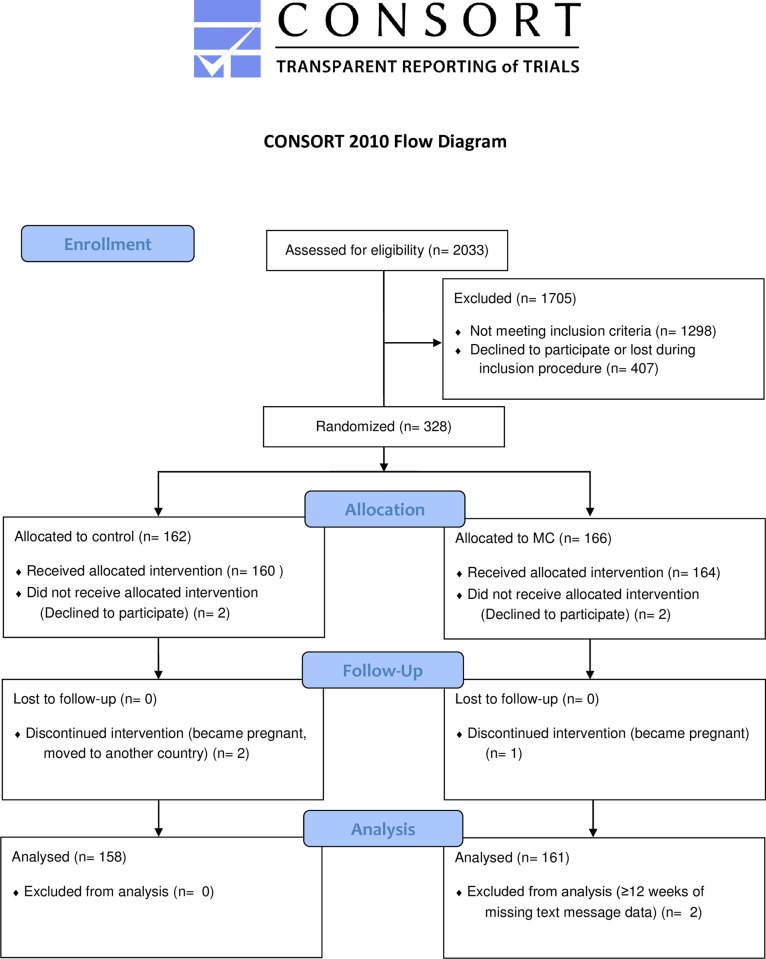
CONSORT 2010 Flow Diagram.MC, Maintenance Care.